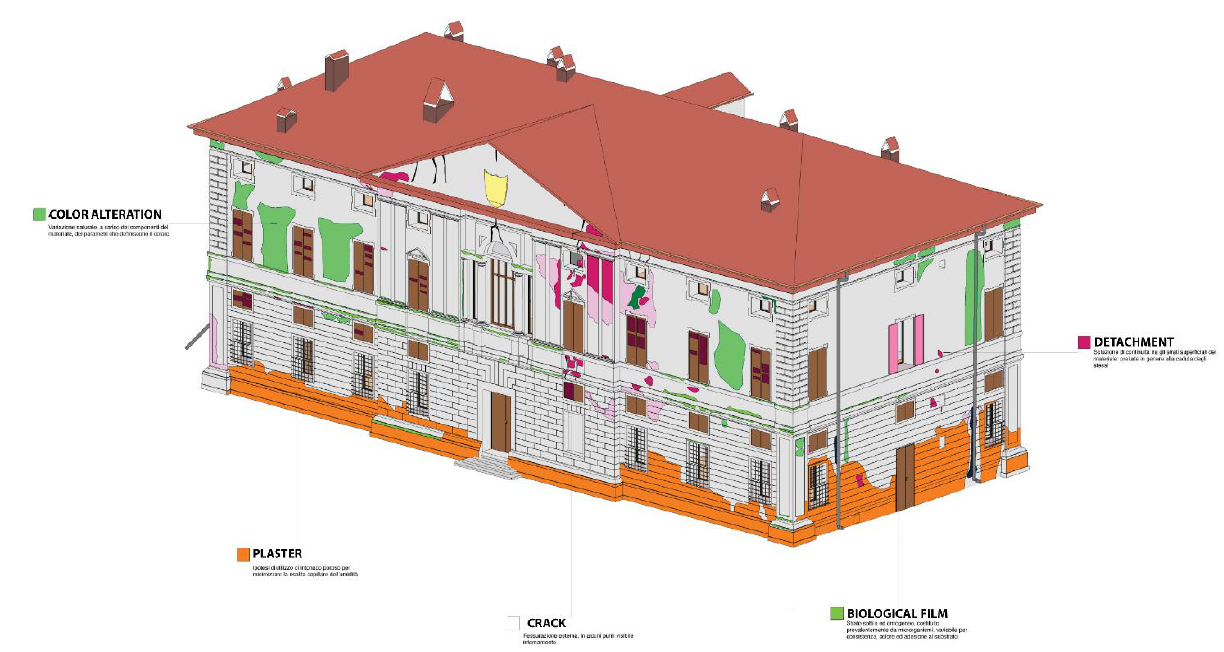
Figure 15. 3D visualization of the parametric model of Villa Sarmoris with the mapped